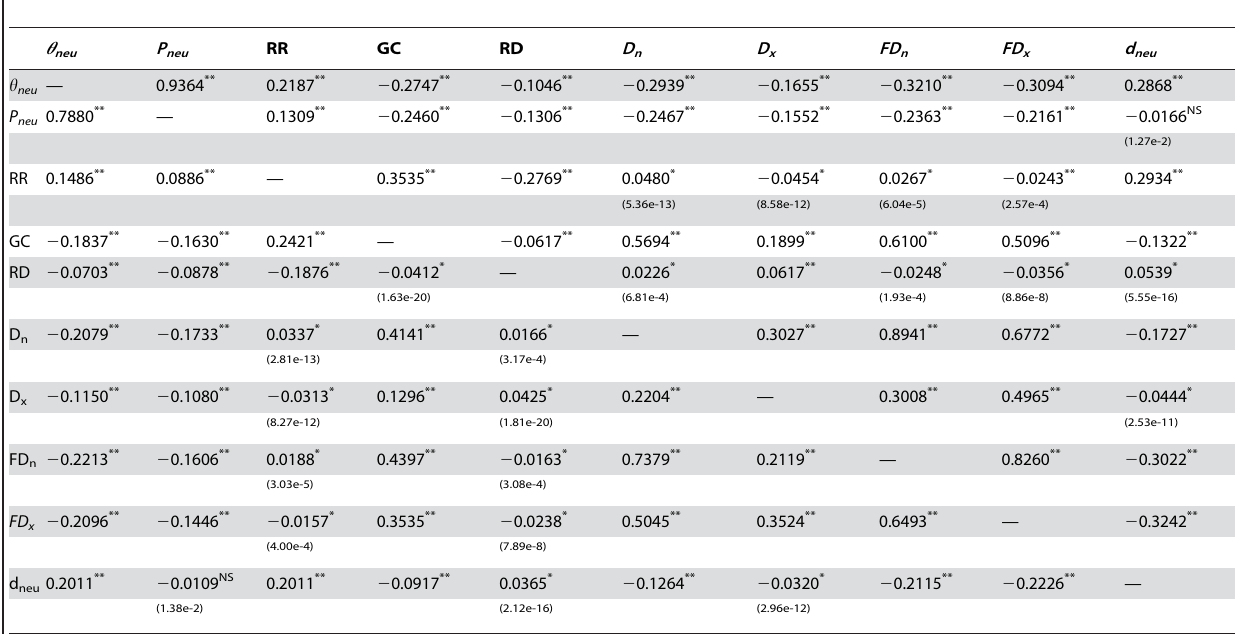
Table 1. Correlation coefficients among the studied variables: the level of neutral polymorphism ( h neu ), the level of normalized neutral polymorphism ( P neu = h neu / d neu ), recombination rate (RR), GC content (GC), the density of simple repeats (RD), the divergence at coding sites ( D n ), the divergence at conserved noncoding region ( D x ), the number of codons ( FD n ), the number of conserved noncoding sites ( FD x ), and the level of neutral divergence ( d neu ).